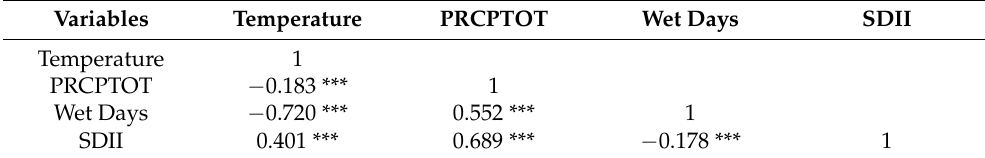
Table 5. Correlation matrix.